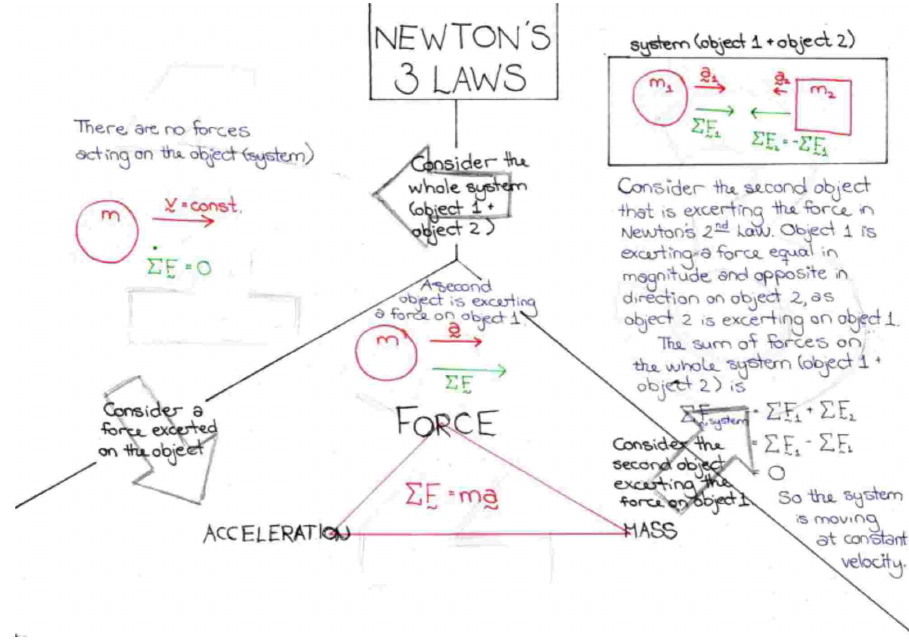
FIG. 2. (cid:1) Color online (cid:2) The link map covering Newton’s three